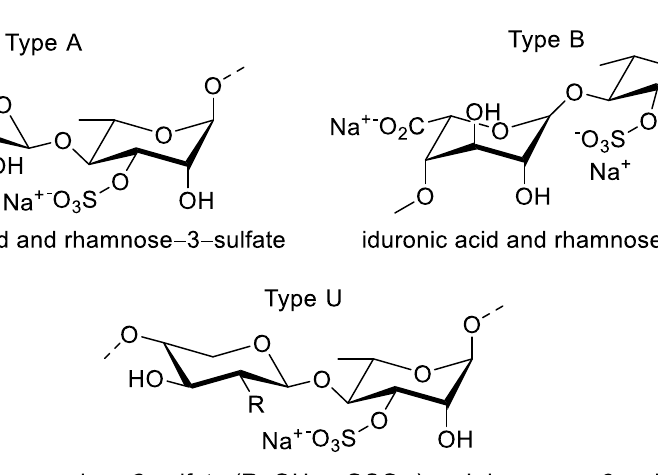
Figure 5. Chemical structure of a typical ulvan